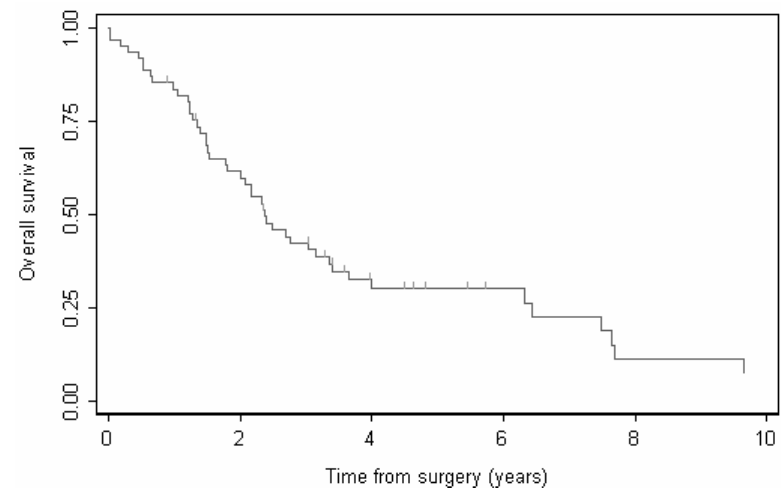
FIGURE 1 . Survival distribution: nephrectomy plus metastasectomy.